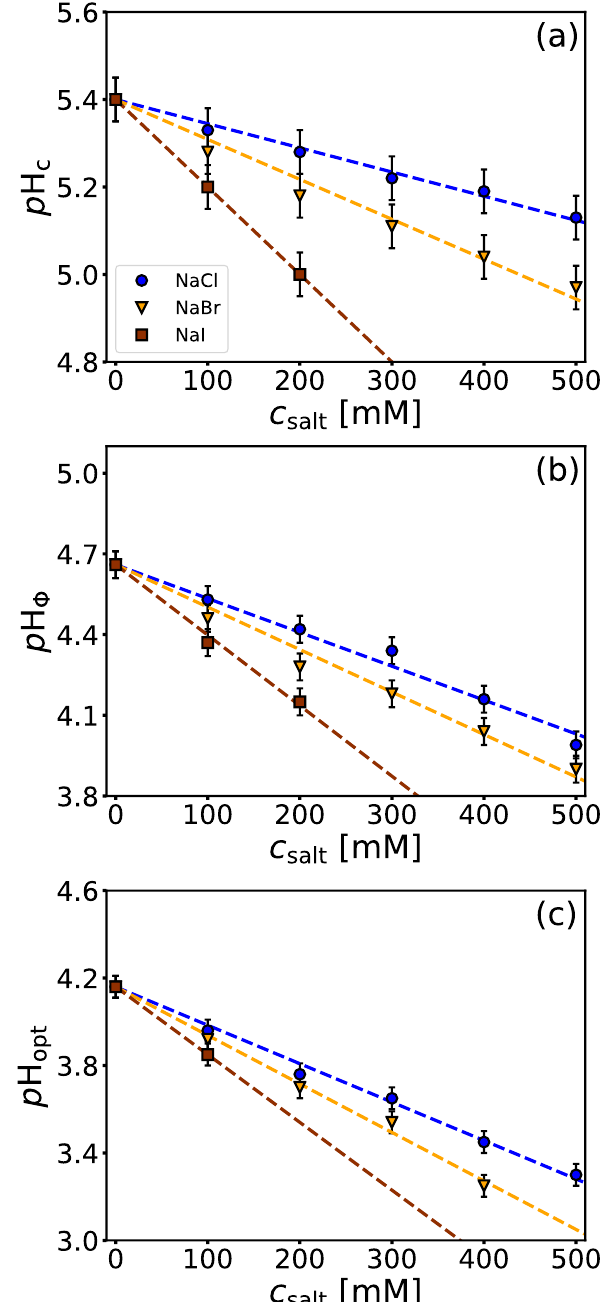
Figure 3. The presence of salt hinders critical structure forming events due to electrostatic screening. Critical p H parameters ( a ) p H c , ( b ) p H Φ , and ( c ) p H opt as a function of salt concentration. Parameters were extracted from turbidimetric titration curves obtained by the acidification of BSA/NaPSS solutions ( r = 40) in acetate buffer ( p H = 5.8, I = 0.1 M) containing NaCl, NaBr, and NaI at 25 °C (cf. Figure